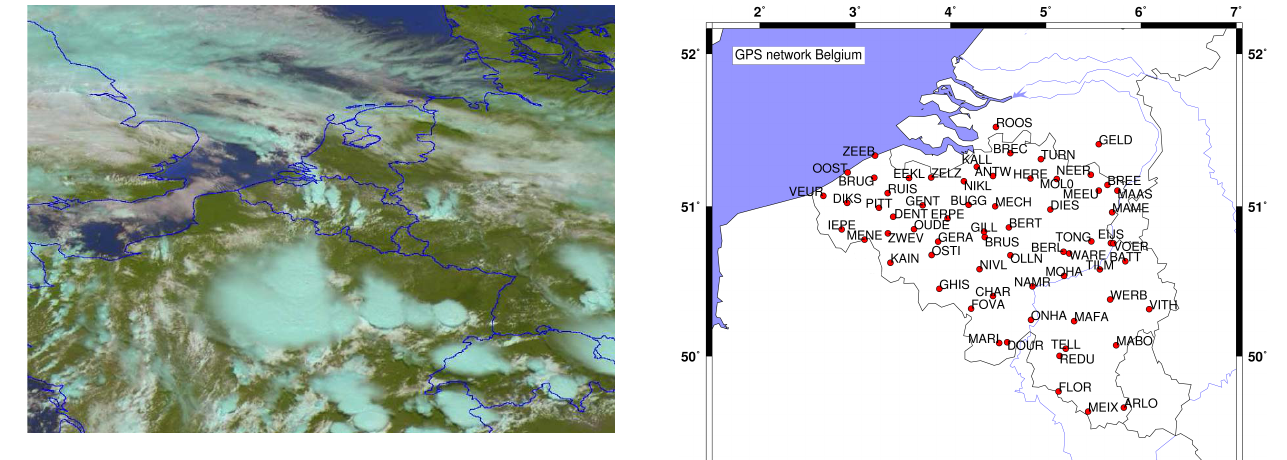
Figure 7. Natural colour composite image of SEVIRI visible chan- nels at 0.6m, 0.8m and 1.6m (29 June 2005 at 12:00UTC). For the cloud, a blue colour indicates that the top of the cloud is composed of ice crystals while the white indicate liquid water droplets.